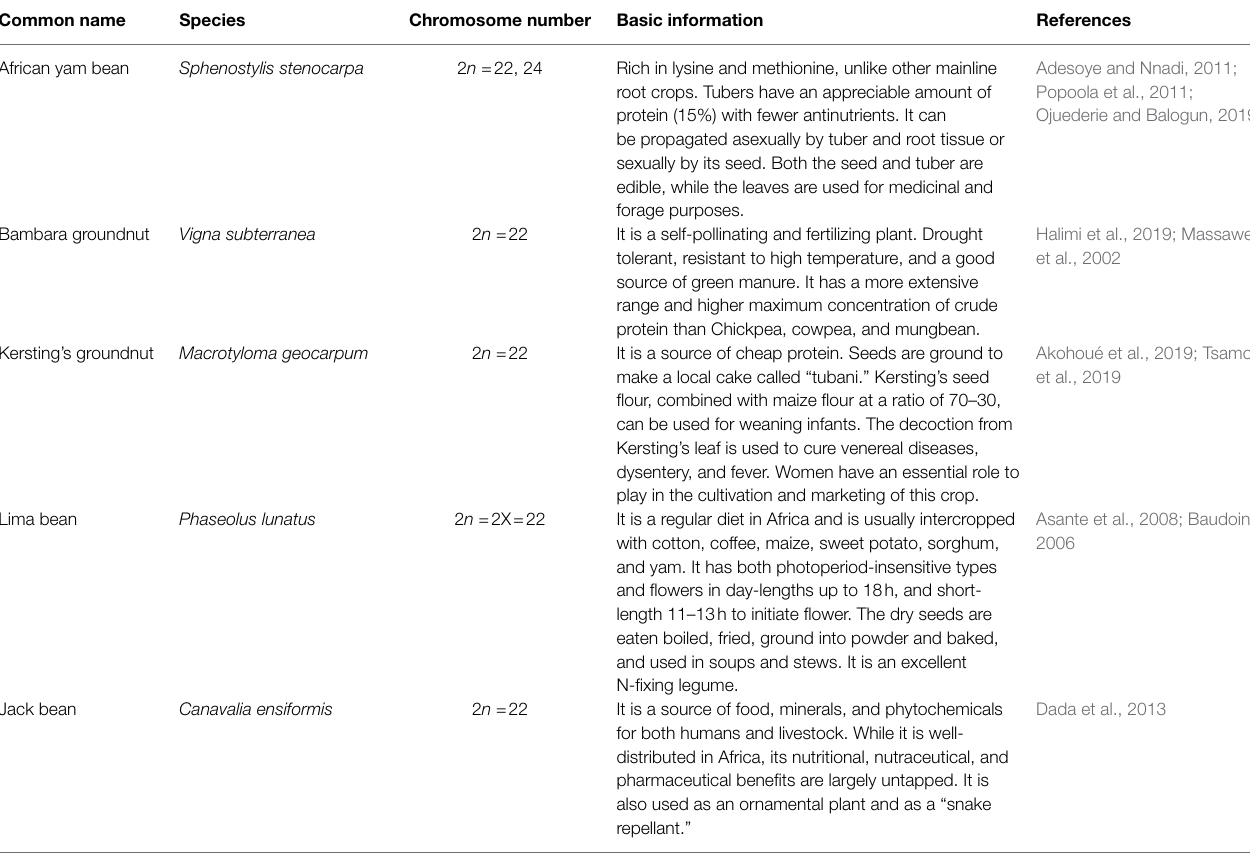
TABLE 2 | Basic scientific information on selected orphan legumes in